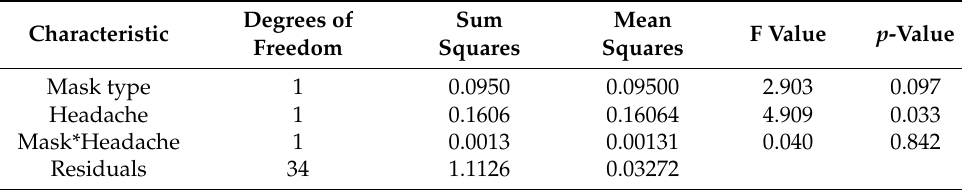
Table 3. Two-way analysis of variance (ANOVA) for type of mask and headache.